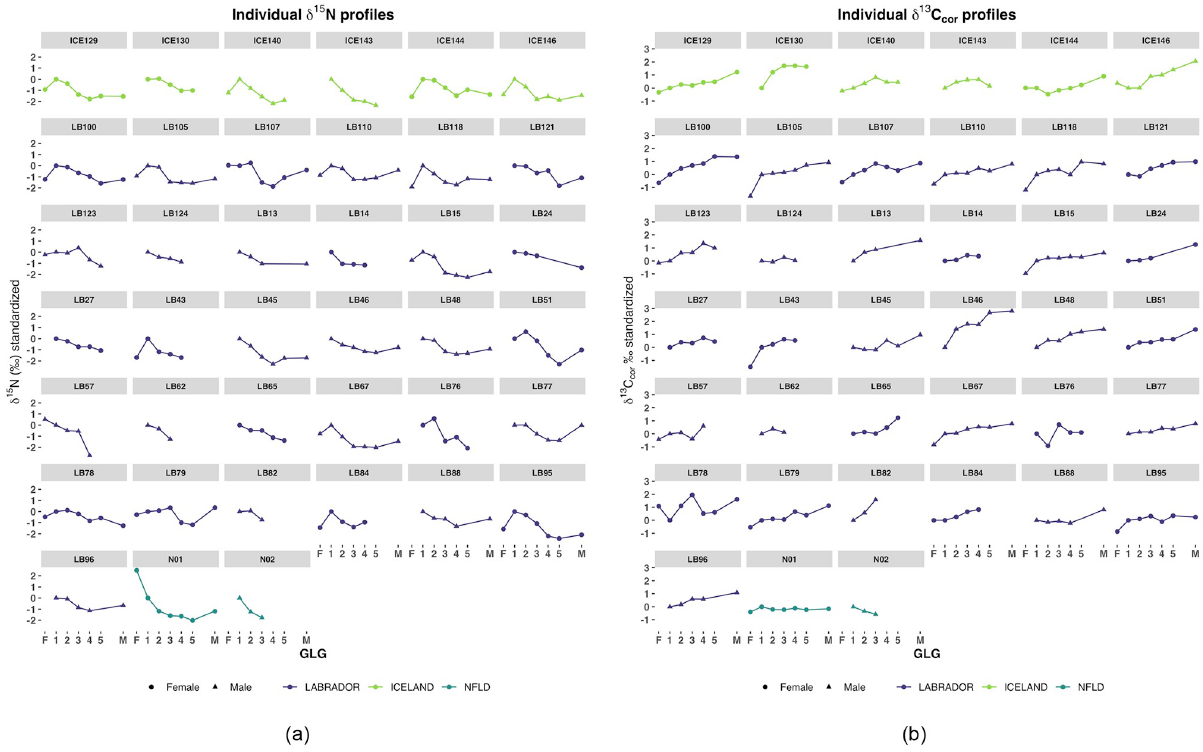
Fig 3. Individual chronologies for (a) δ 15 N and (b) δ 13 C for each region. Regions are indicated by colour. Isotope values were standardized to be relative to GLG 1 for prior (fetal dentine = F) or subsequent (years 2—mature = M) GLGs. Sex of specimen is indicated by circle (female) and triangles